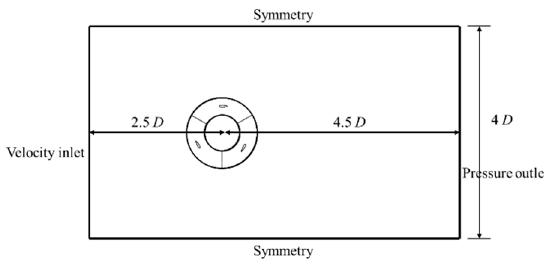
Figure 1. Computational domain and boundary conditions.